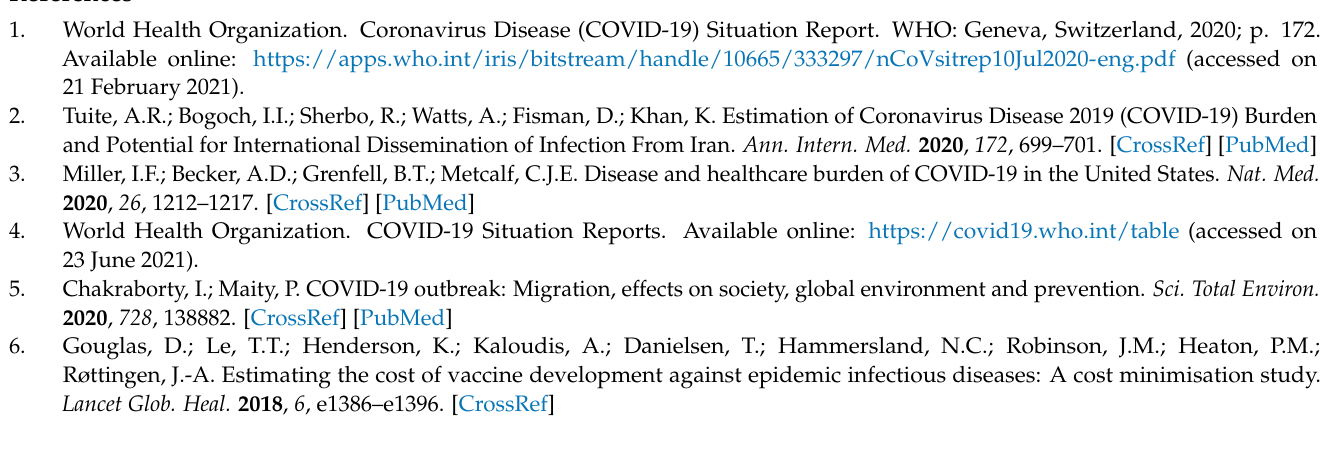
Tool. Supplementary Table S3: Association between the demographic data of the participants and their beliefs regarding myths about the COVID-19